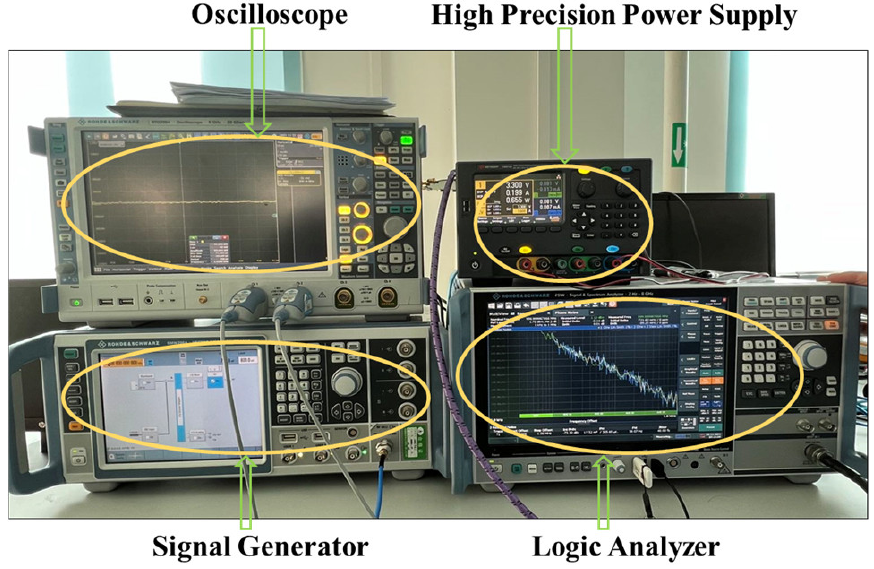
Figure 10. Test equipment for the AD9230 test.